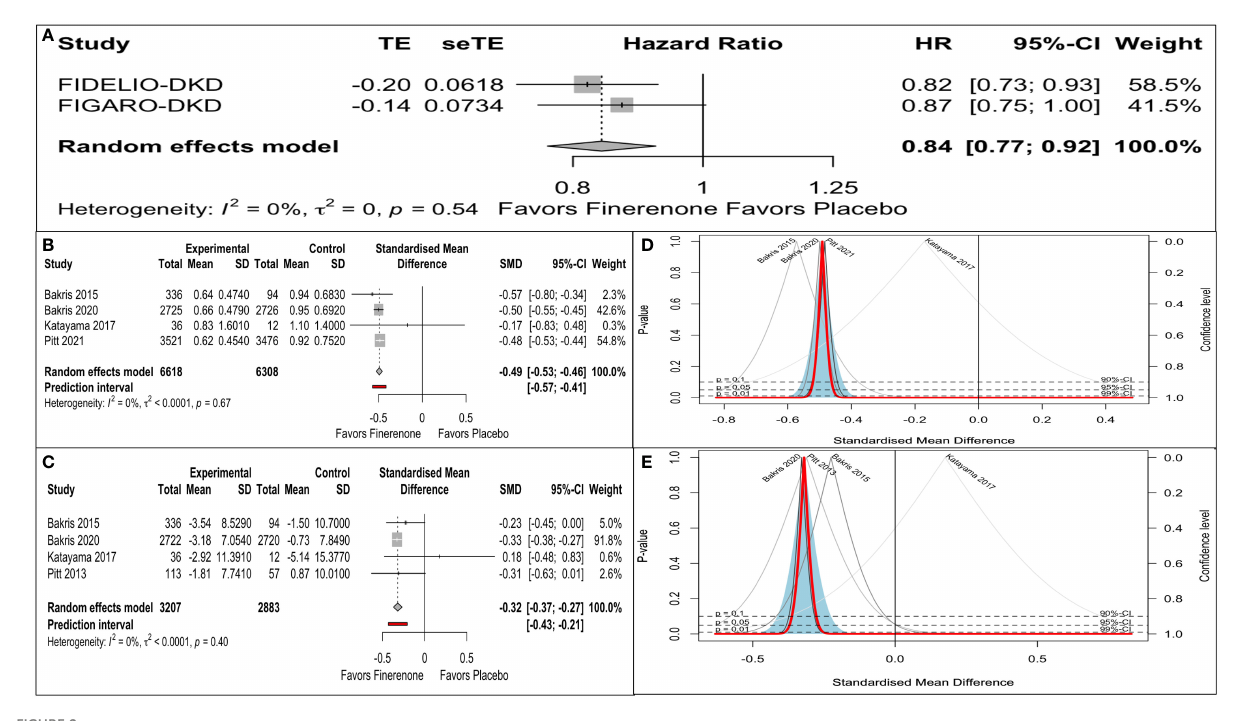
FIGURE 2 Finerenone versus placebo on: (A) Renal composite (Forest plot): hazard ratio (HR). (B) Reduction in UACR (Forest plot): Standardized mean difference (SMD). (C) eGFR decline (Forest plot): Standardized mean difference (SMD). (D) eGFR decline (Drapery plot). (E) Reduction in UACR (Drapery